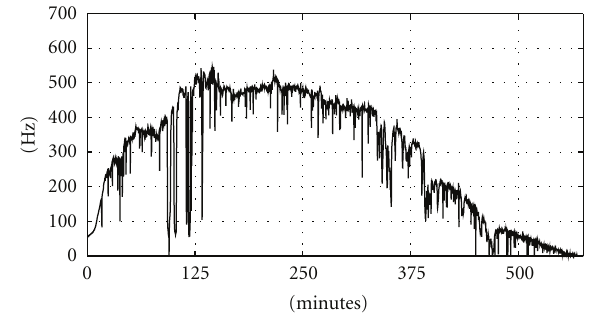
Figure 12: Intercepted solar